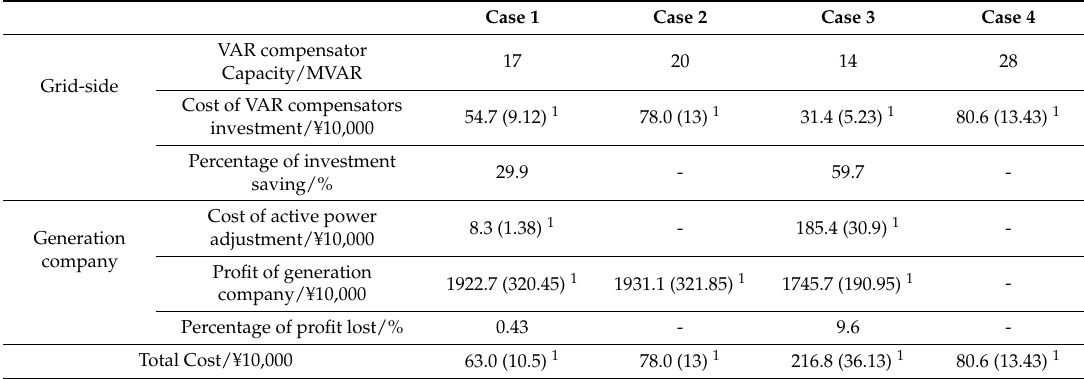
Table 5. Total costs of four